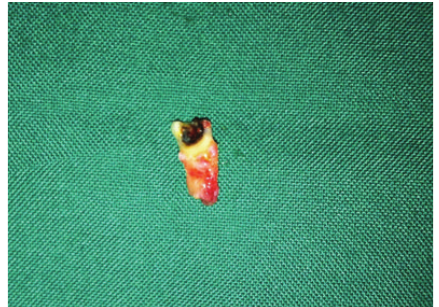
Figure 6: Showing extracted paramolar of case-2.